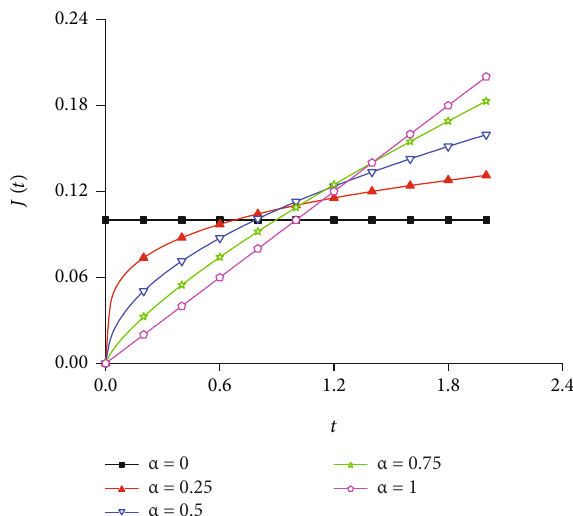
Figure 4: Strain characteristics of the Abel dashpot.